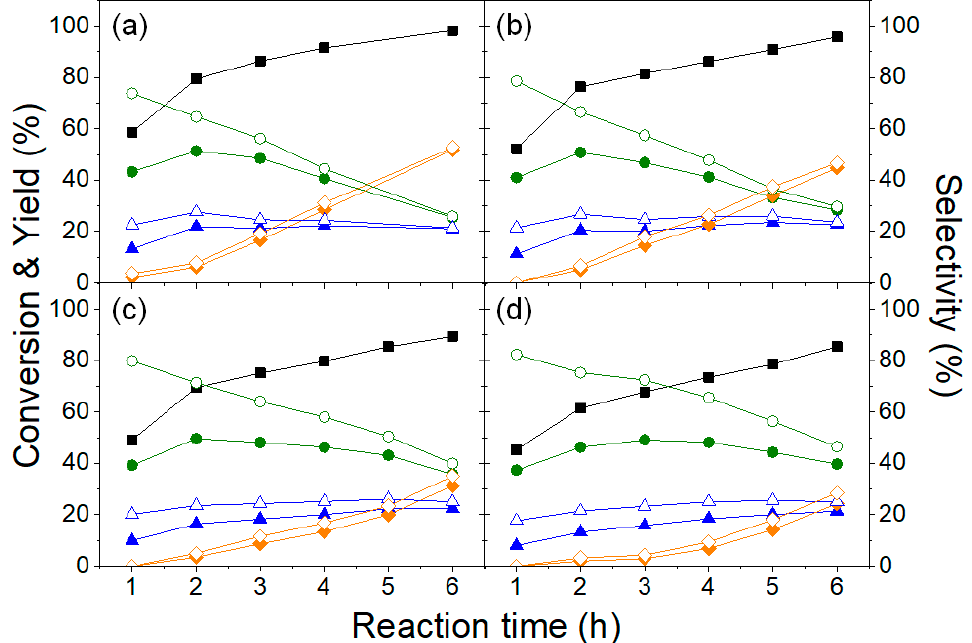
Figure 2. The influence of reaction time on the etherification reaction of glycerol in the presence of 3 wt.% of Na-zeolite with ( a ) 0 wt.%, ( b ) 0.1 w.t%, ( c ) 0.2 wt.%, and ( d ) 0.3 wt.% of NaHSO 4 (- ■ -: conversion of glycerol, - ● -: yield of DG, - ▲ -: yield of TG, - ♦ -: yield of others - ○ -: selectivity of DG, - Δ -: selectivity of TG, - ◇ -: selectivity of others, reaction temperature: 280 °C).